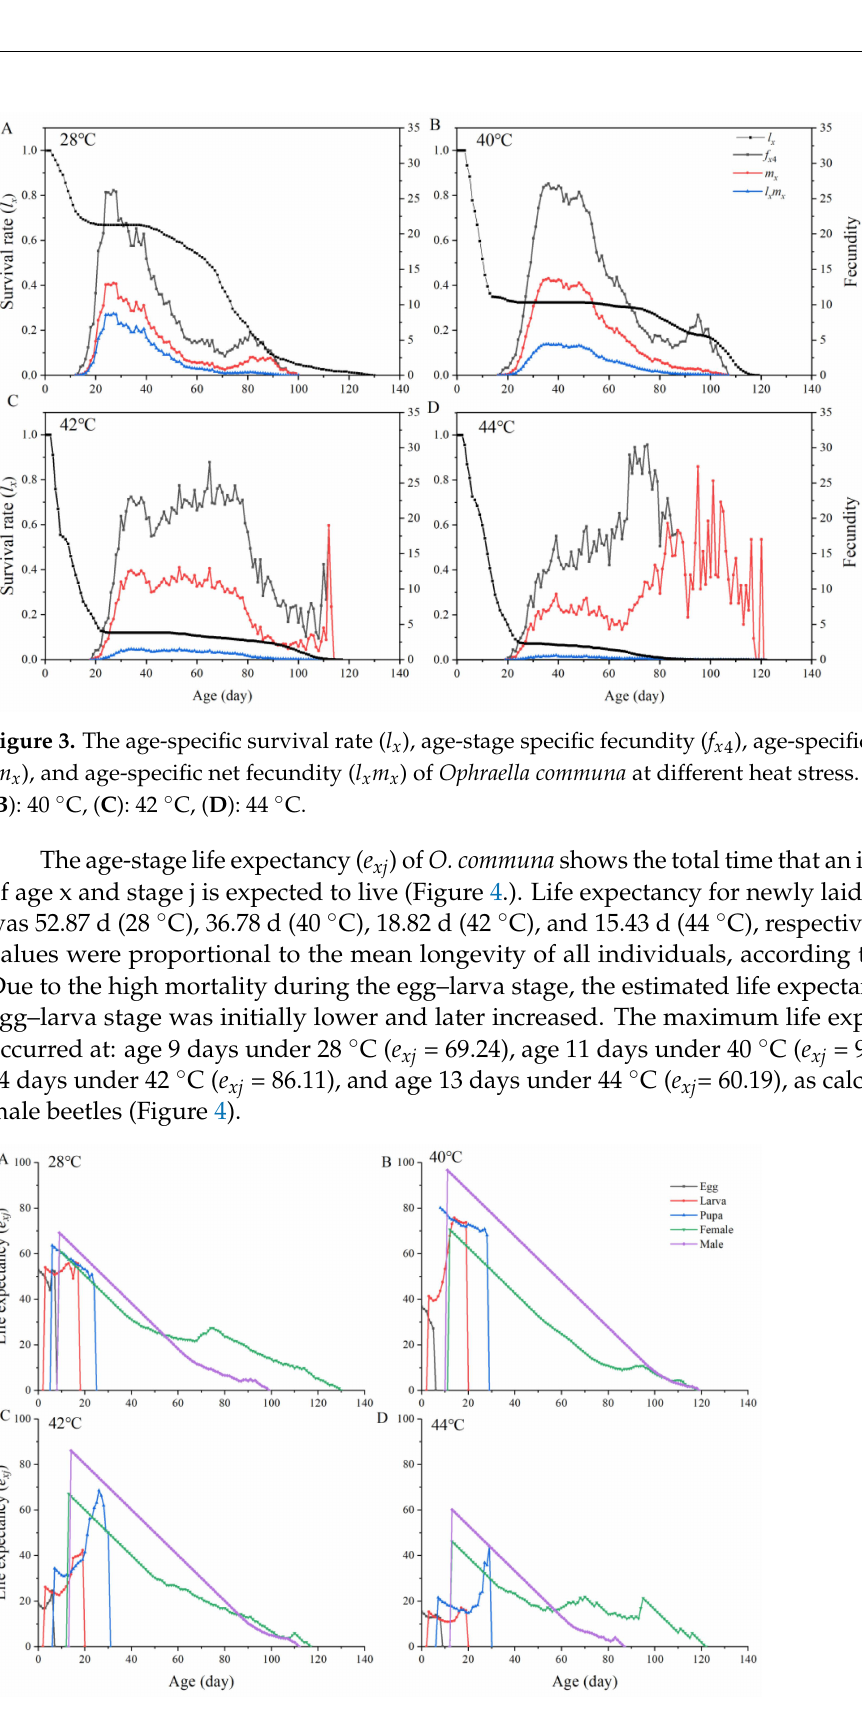
Figure 4. The age-specific life expectancies ( e xj ) of Ophraella communa reared under different tempera- tures. ( A ): 28 ◦ C, ( B ): 40 ◦ C, ( C ): 42 ◦ C, ( D ): 44 ◦